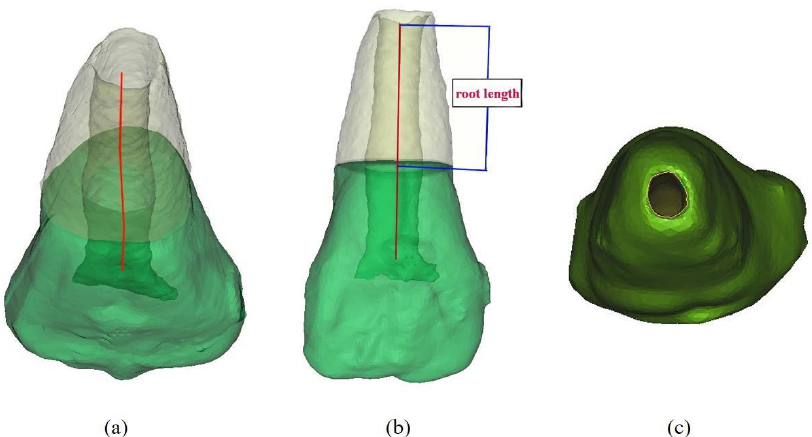
Figure 1. Measurement of the root length and apical foramen area of the 3D reconstructed tooth. ( a ) the center line (CT line) was created in the center of the root canal. The cementoenamel junction was generated as the horizontal plane (CE plane); ( b ) the root length was determined from the intersection of the center line and the horizontal plane to the apical foramen; ( c ) apical view of the tooth. The apical foramen was outlined, and its area was